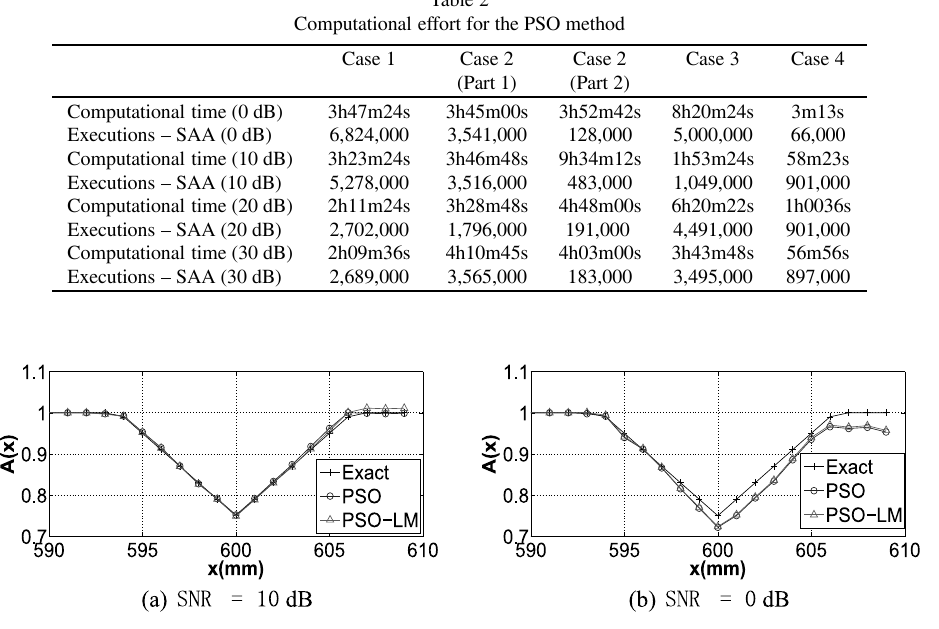
Fig. 13. Damage identi fi cation with two levels of SNR, Case 2 (Part 2).